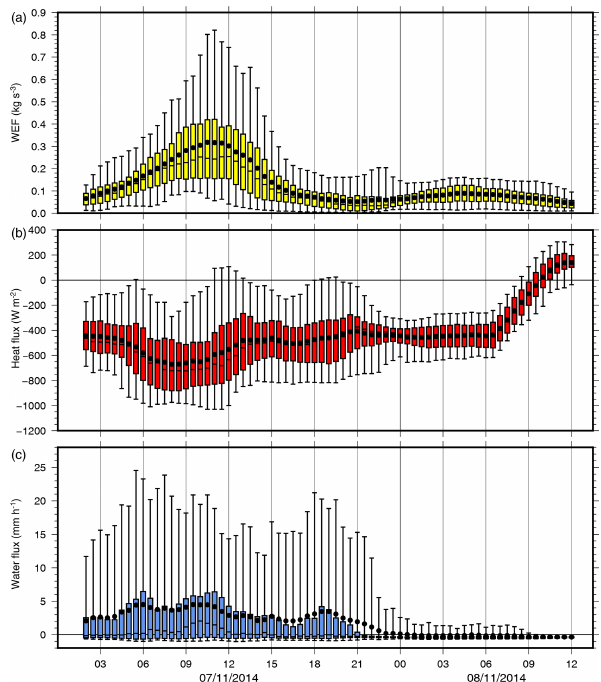
Figure 4. Time series of the median values of the wind energy flux (a) , net heat flux (b) , and water flux (positive values correspond to precipitation) (c) in the SFA. The boxes correspond to the 25% and 75% quantiles and the whiskers to the 5% and 95% quantiles. The solid black dots correspond to the mean